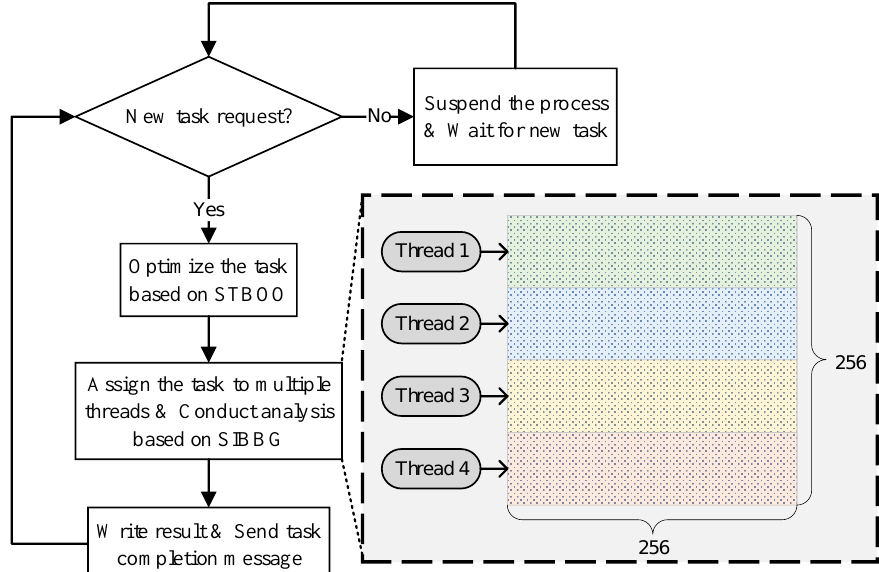
Figure 7. Buffer-Overlay analysis of a tile range with 256 × 256 pixels in an MPI process with 4 OpenMP